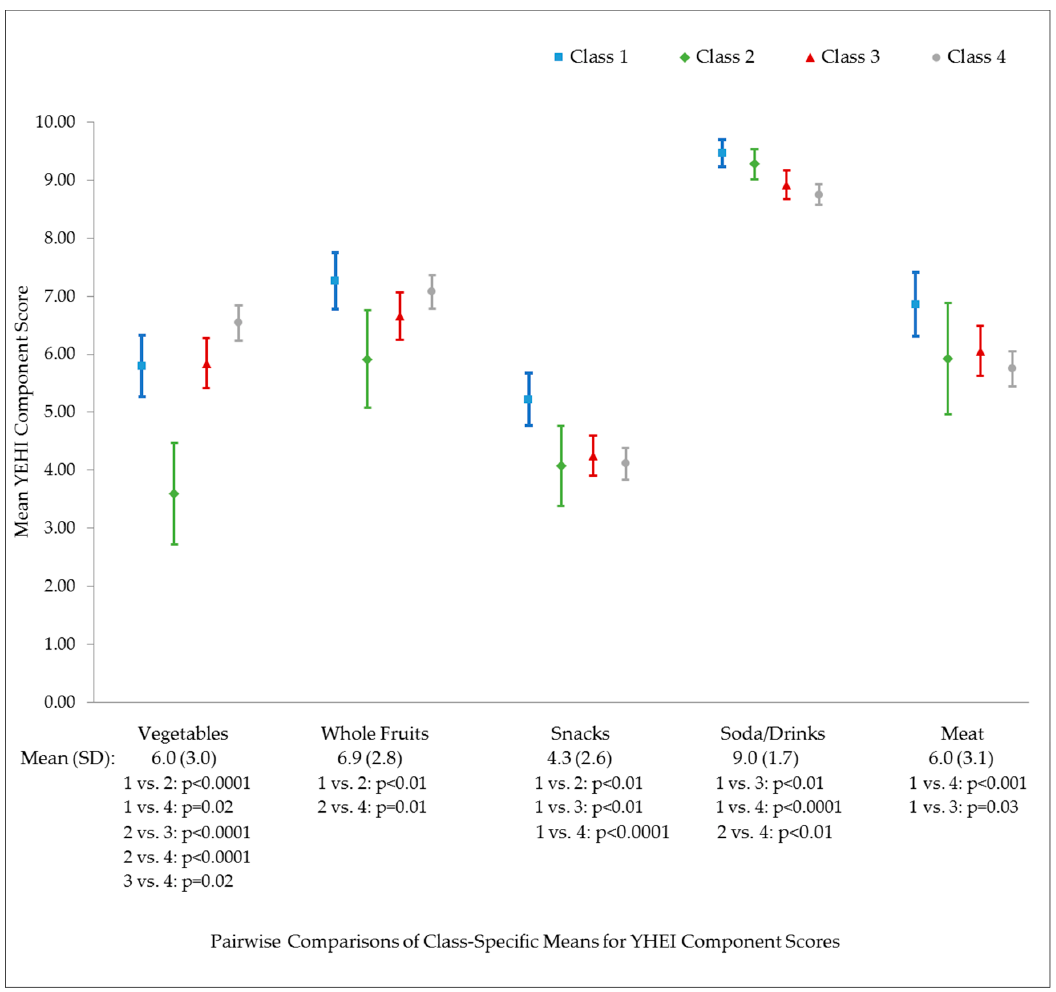
Figure 1. Comparison of adjusted 1 mean YHEI component scores across latent classes 2 among 969 Project Viva